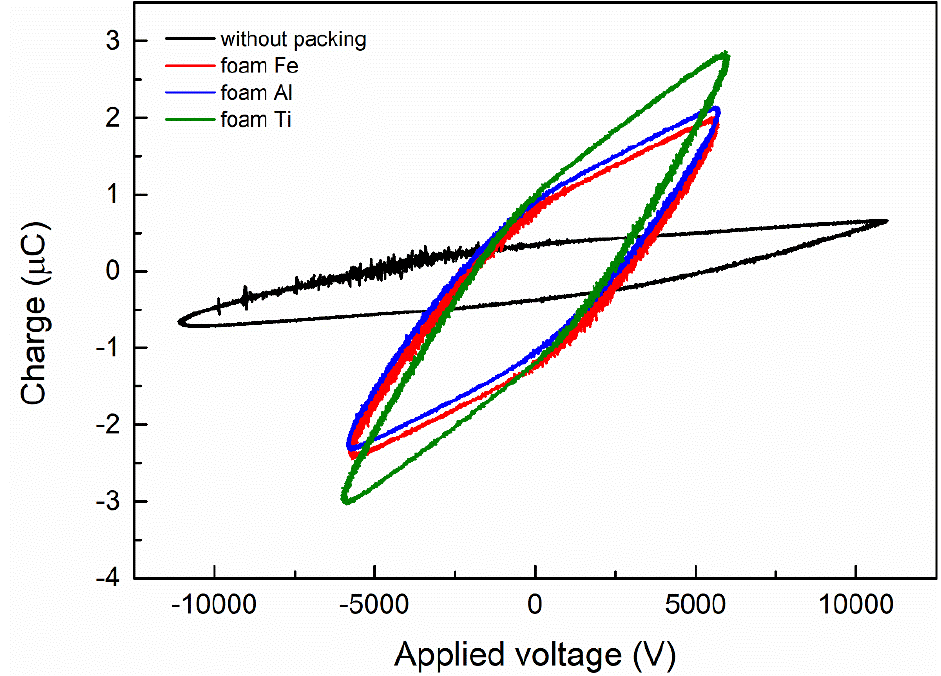
Figure 3. Lissajous figure of CO 2 decomposition in the DBD reactor with or without foam metals.